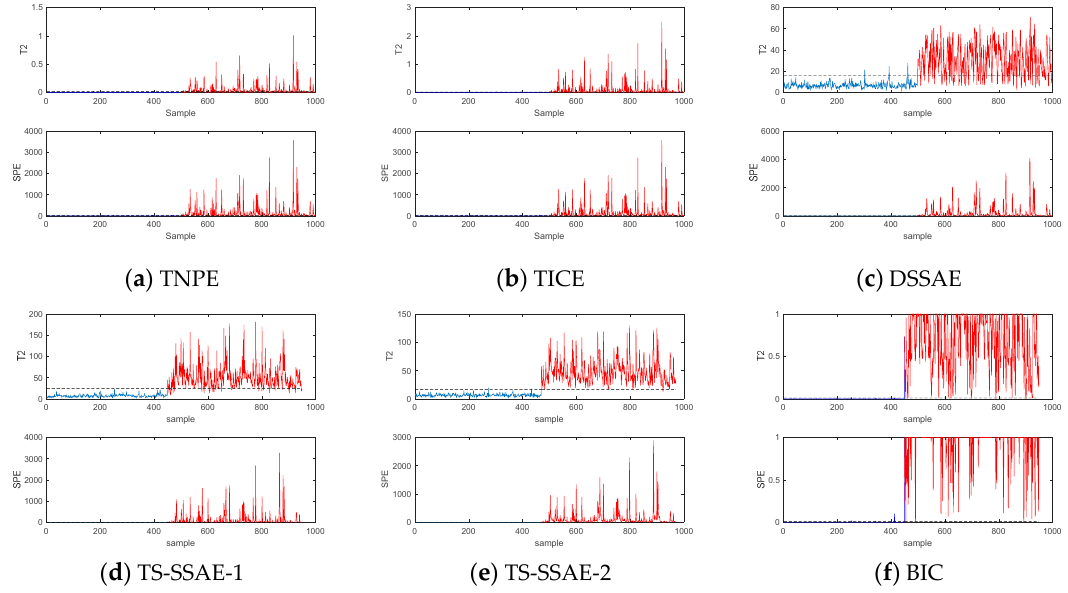
Figure 6. Monitoring results of fault 2 in the case study. Table 1. Result of fault detection in the case study (FAR) /%.